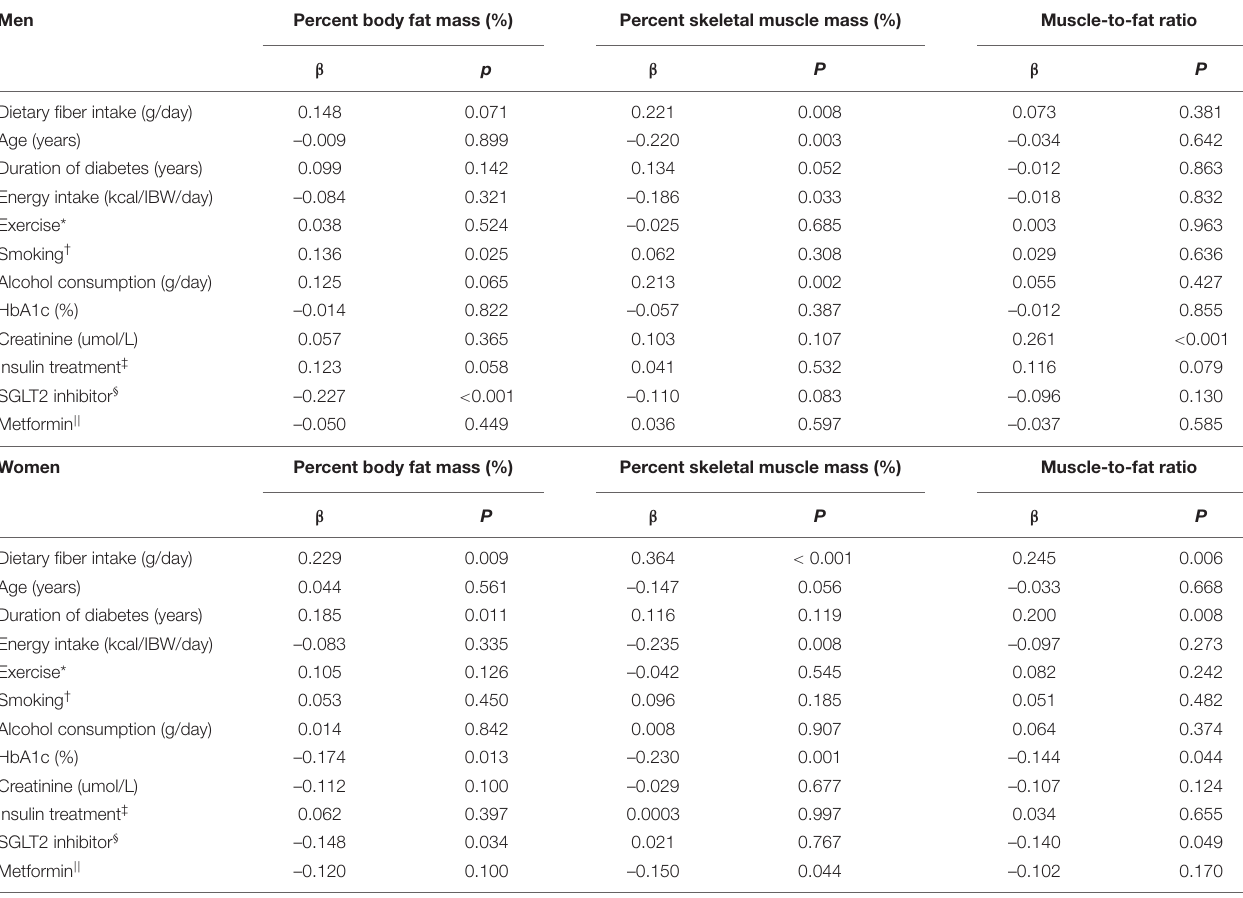
TABLE 4 | Multiple regression analysis on percent body fat mass, percent skeletal muscle mass, and muscle-to-fat ratio. Men Percent body fat mass (%) Percent skeletal muscle mass